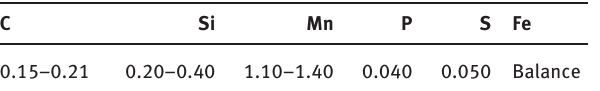
Table 1: The chemical composition of AISI 1518 steel (in weight